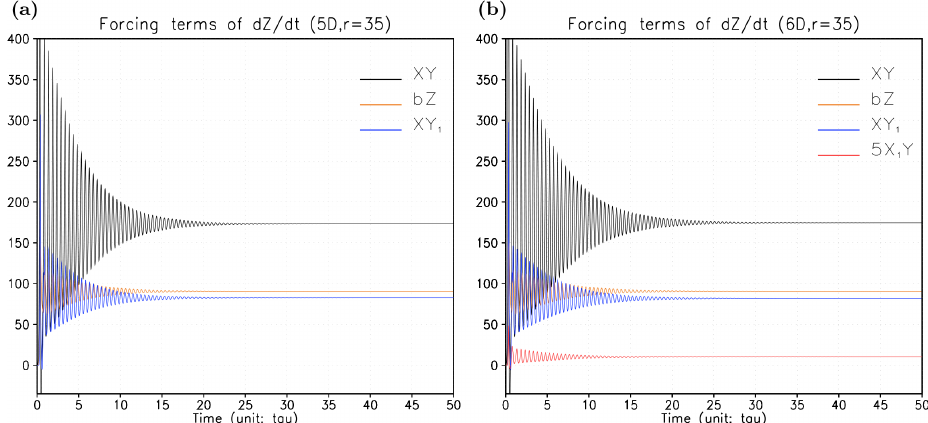
Figure 3. Forcing terms of d Z/ d τ with r = 35, which are from Eq. (12) for the 5DLM of Shen (2014a) (a) and Eq. (10) for the 6DLM (b) , respectively. The black and orange lines represent XY and bZ , respectively, while the blue and red lines represent XY 1 and 5 X 1 Y , respec-